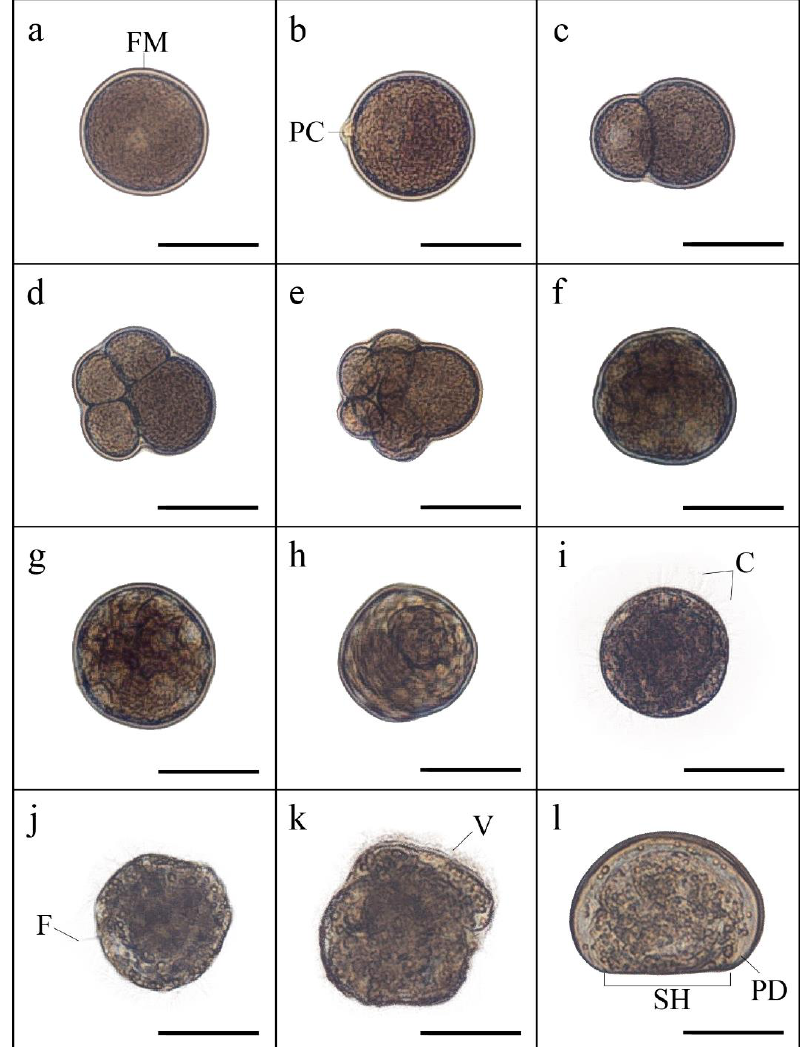
Figure 3. Embryonic development of the surf clam Mesodesma donacium at 16 °C: ( a ) oocyte with fertilization membrane (FM); ( b ) release of first polar corpuscle (PC); ( c ) first two-cell embryo segmentation (2 blastomeres); ( d ) second segmentation (4 cells); ( e ) third segmentation (8 cells); ( f ) morula; ( g ) blastula; ( h ) rotary blastula; ( i ) gastrula with cilia (C); ( j ) trochophore larva with apical flagellum (F); ( k ) trochophore larva with extended vellum (V); ( l ) D larva with straight hinge (SH) and prodisoconch I (PD). Scale bar = 50 µ m.